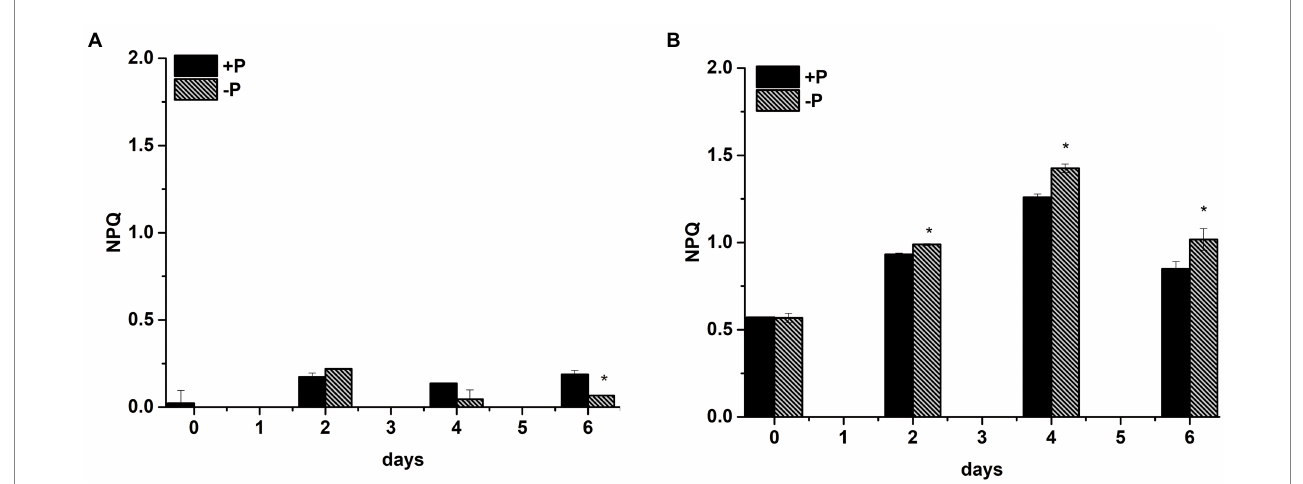
FIGURE 10 Non-photochemical quenching (NPQ) capacity of S . costatum (A) and P . globosa (B) in +P and − P groups. Error bars show the mean ± standard error (SE) of triplicate treatments. Superscripts indicate significant differences between +P group and − P group according to a two-way ANOVA with a post- hoc test (* p <